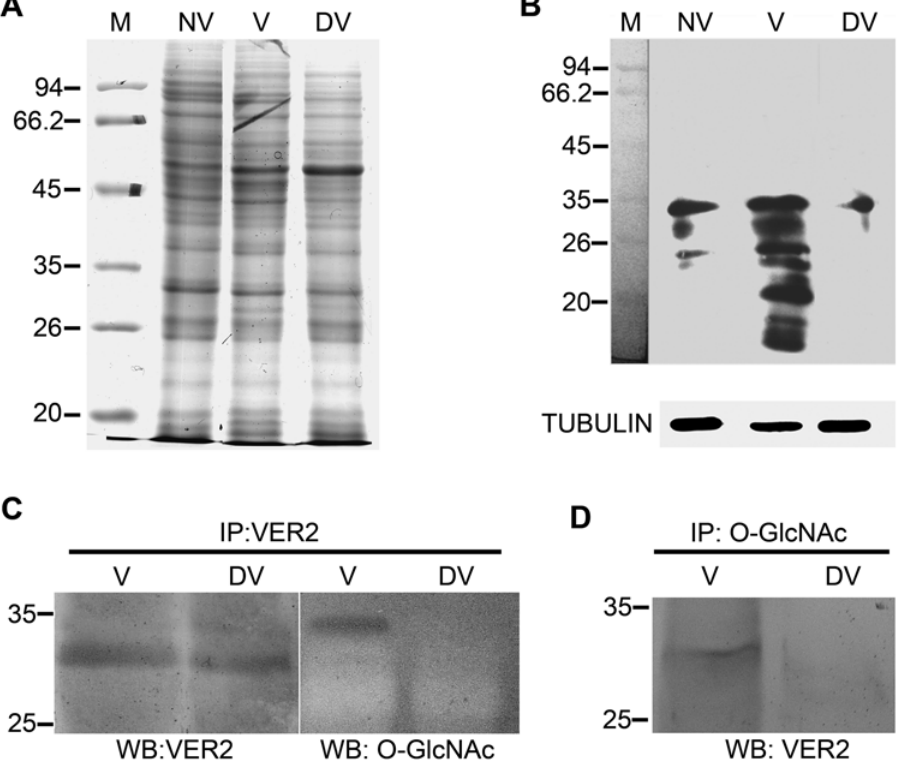
Figure 4. Detection of O -GlcNAc-modified proteins and their association with VER2 in vernalized and devernalized wheat plants. (A) SDS-PAGE results stained with coomassie blue. (B) Immunoblot analysis of O -GlcNAc-modified proteins in nonvernalized, vernalized and devernalized plants with O -GlcNAc site-specific antibody CTD110.6. Tubulin was immunoblotted as a loading control of total proteins with anti-tubulin polyclonal antibody. (C) Proteins from vernalized and devernalized wheat plants were immunoprecipitated with anti-VER2 antibody and detected with anti-VER2 and CTD110.6 antibodies, respectively. An O -GlcNAc modified protein with a molecular weight of about 35 kD was identified in VER2 immunoprecipitates from vernalized materials; no blotting signals for O -GlcNAcylated proteins were detected in devernalized materials. (D) VER2 was identified in O -GlcNAc immunoprecipitates from vernalized plants but not from devernalized plants. M, molecular weight markers; NV, nonvernalized; V, vernalized; DV, devernalized. IP, immunoprecipitate; WB, western blotting.